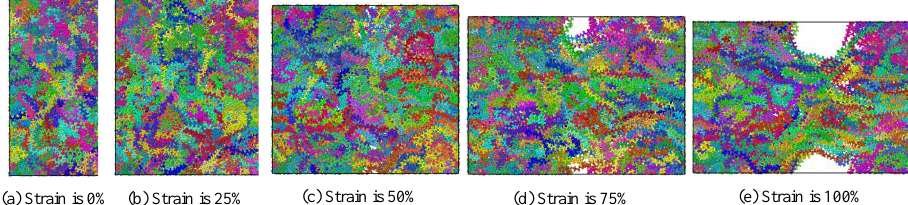
Figure 11. Tensile process of the mixture polyethylene structure.